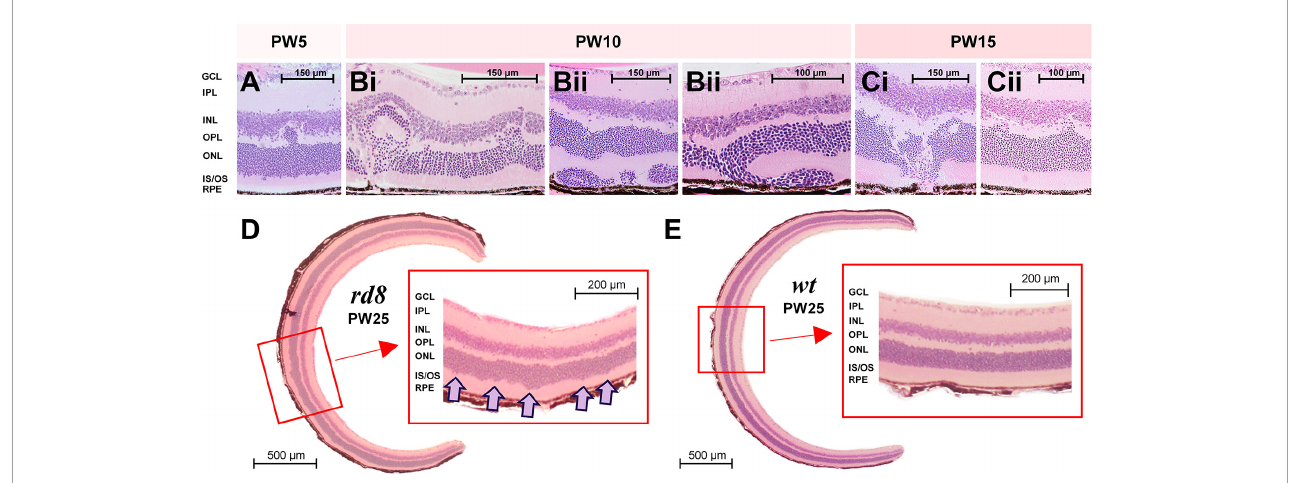
FIGURE2 Diverse shapes of retinal folds were found in H&E staining images of rd8 retinas at various ages. (A) A retinal fold was observed from a retina of a rd8 mouse sacrificed in postnatal weeks (PW) 5. Scale bar is displayed on each panel. GCL, ganglion cell layer; IPL, inner plexiform layer; INL, inner nuclear layer; OPL, outer plexiform layer; ONL, outer nuclear layer; IS/OS, inner segment/outer segment of photoreceptor; RPE, retinal pigment epithelium. (B) Same as panel (A) but from rd8 animals sacrificed in PW10. Retinas shown in panels (Bi,Bii) are from two different animals. Two panels marked as (Bii) show different areas of the same retina. (C) Same as panel (A) but from an rd8 animal sacrificed in PW15. Retinas shown in panels (Ci,Cii) are from the same animal but two different retinas. (D) Cross-sectional image of the whole retina of a PW25 rd8 mouse. (inset) A magnified view showing a wiggly borderline between ONL and IS/OS layer. Wiggly spots are marked with pink arrows. (E) Same as D but from an age-matched wild-type ( wt ) mouse (PW25). Inset shows a clear borderline between ONL and IS/OS layer.